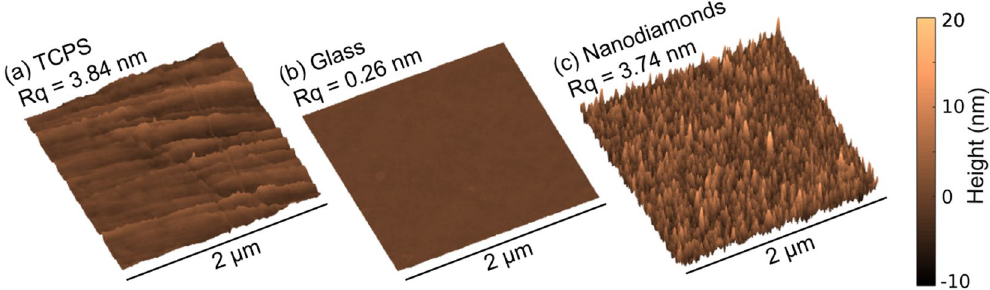
Figure 1. Atomic force microscopy (AFM) scan of 2 µ m square ( a ) TCPS, ( b ) Glass and ( c ) Nanodiamonds. R q = root mean square